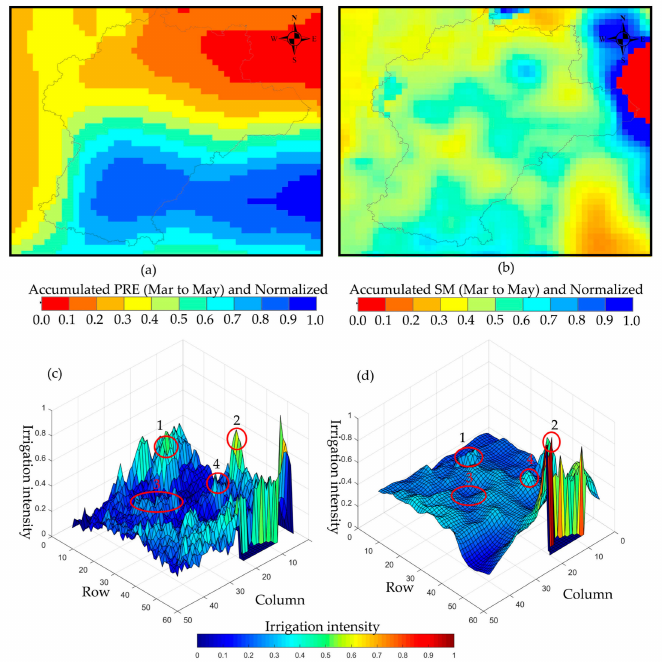
Figure 11. Comparison of the method proposed in this paper with the time-integrated and SM normalized irrigation signal detection methods. ( a ) Accumulated PRE and normalized result, ( b ) accumulated SM and normalized result, ( c ) irrigation intensity calculated by this paper proposed method, and ( d ) time-integrated and SM normalized irrigation signal detection methods. Both normalized results and irrigation intensity are dimensionless variables.